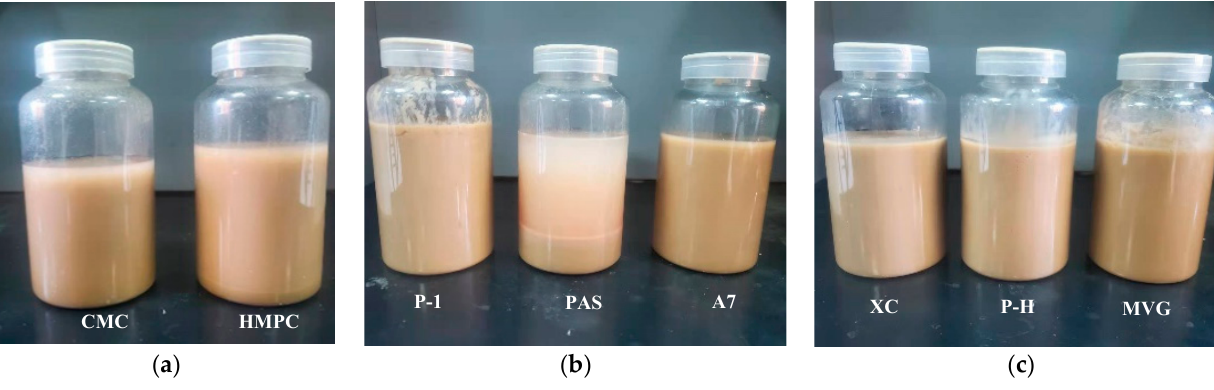
Figure 2. Delamination of polymer and calcium bentonite into sea water suspensions for 16 h. ( a ) Cellulose polymer, ( b ) synthetic polymer, ( c ) natural macromolecule polymer.